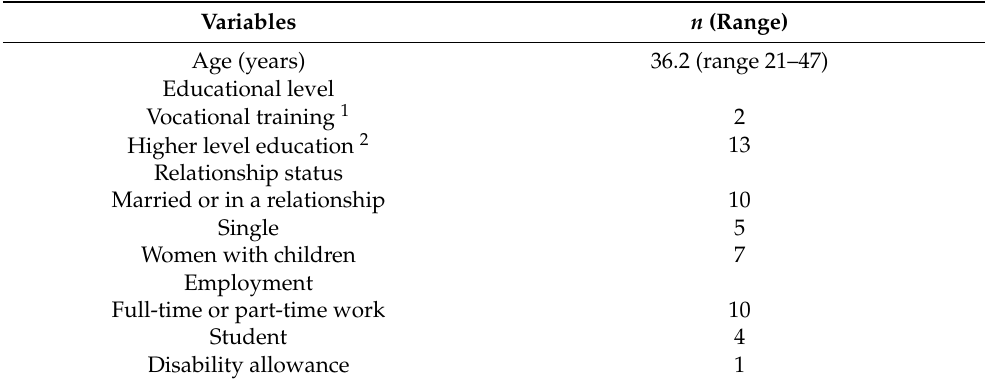
Table 1. Background characteristics of the study population, n =